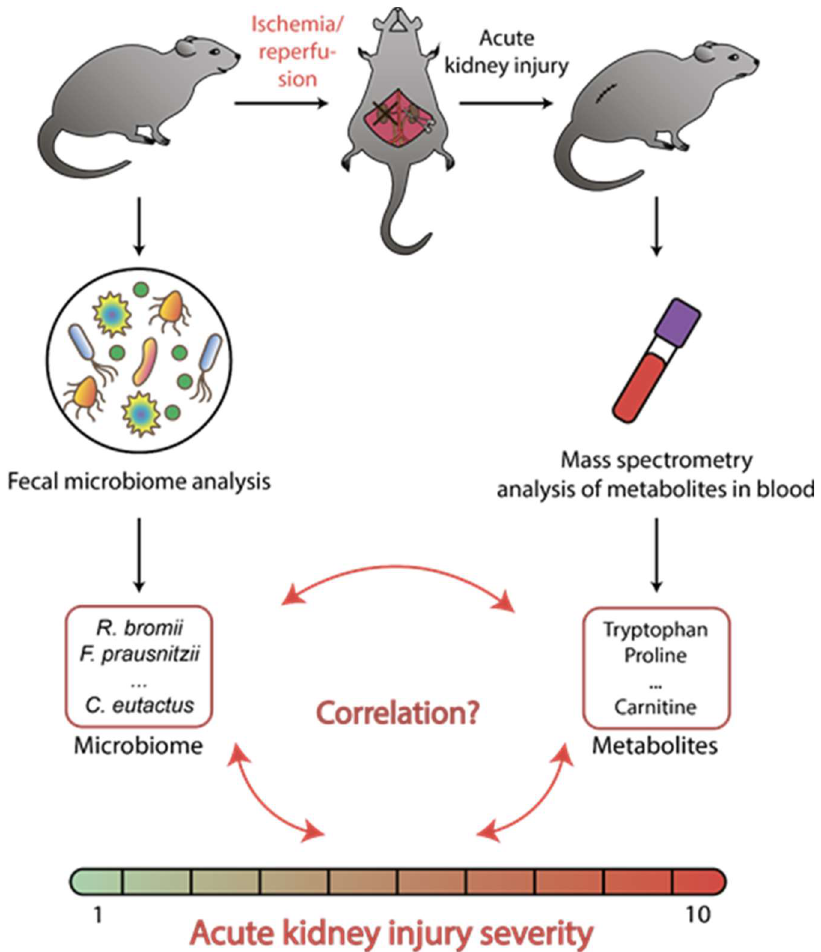
Figure 1. Experimental design. The composition of microbiota was evaluated in fecal samples collected immediately before the modeling of acute kidney injury, as soon as the blood samples were taken after renal ischemia/reperfusion and were analyzed for a number of metabolites (serum creatinine, urea, acylcarnitines, and amino acids).